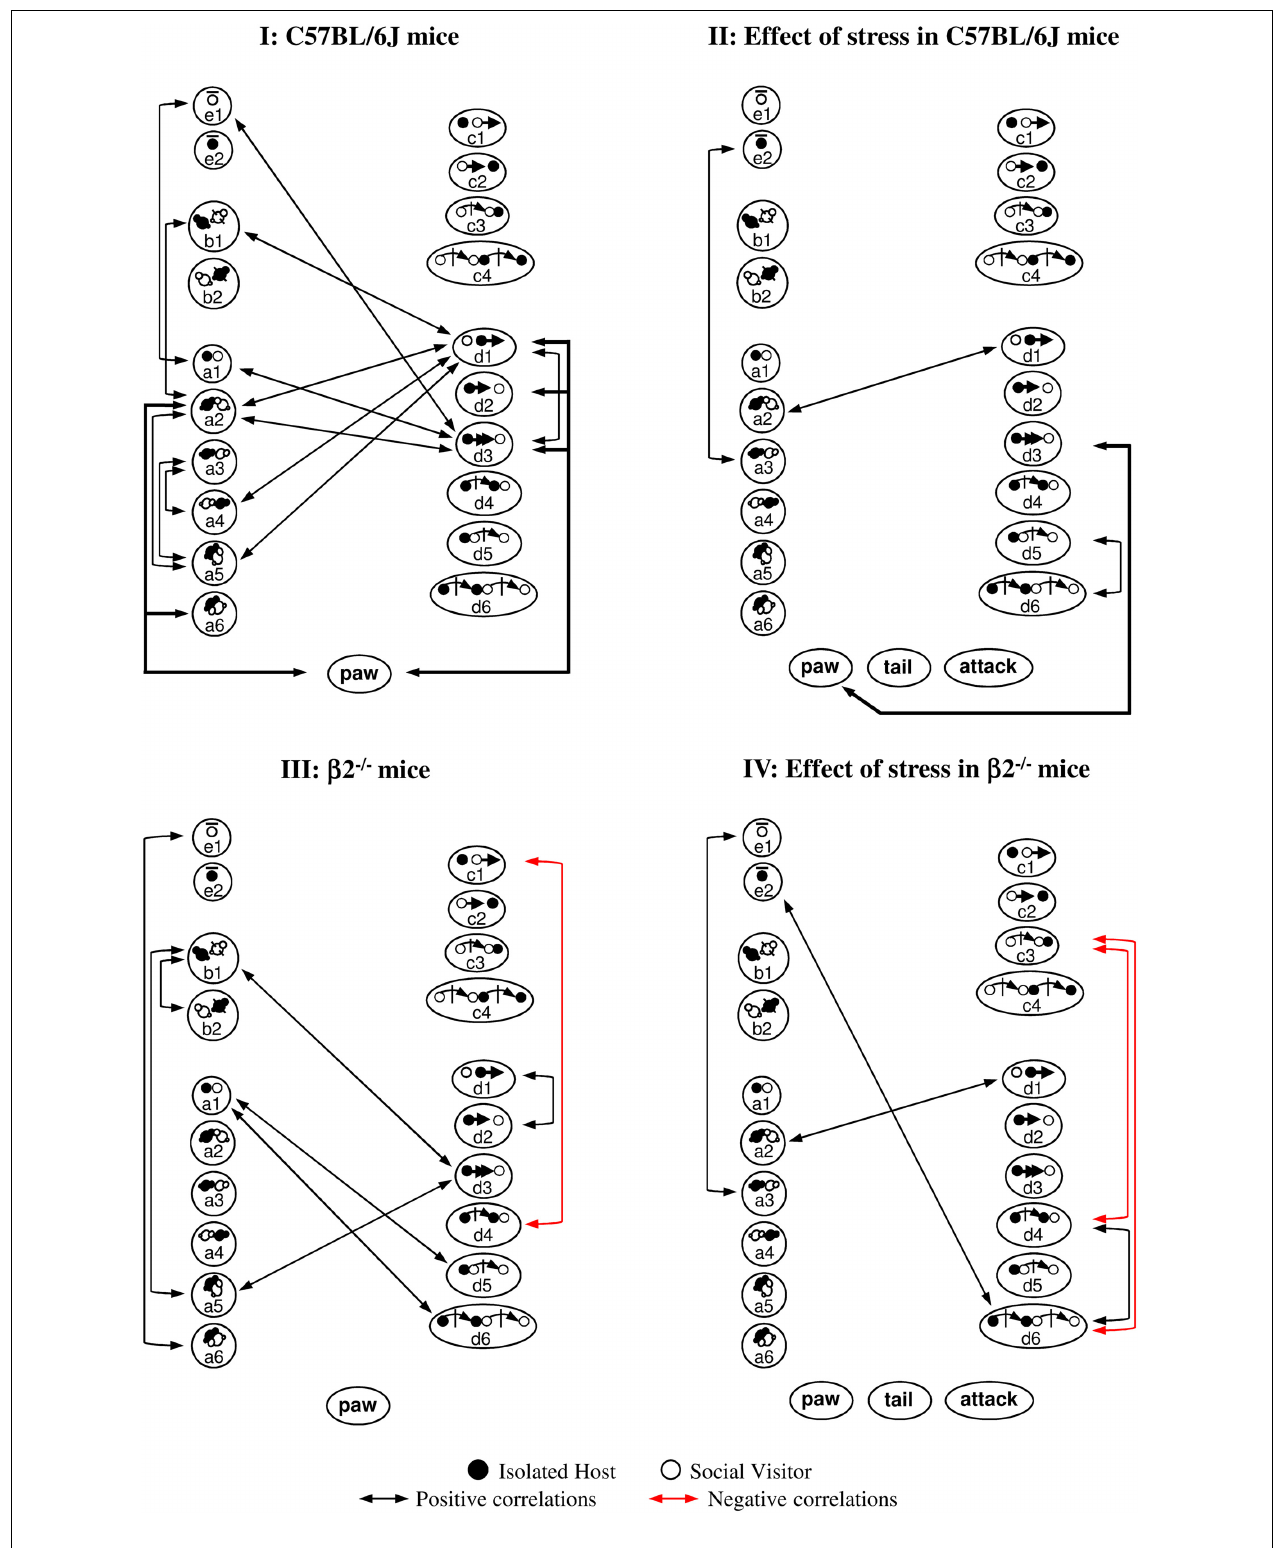
(0 . 0000002 ≤ p ≤ 0 . 002), red arrows negative ones ( p = 0 . 0000002). (I) C57BL/6J mice. All correlations were positive. Many contact events were correlated between them and some with d3 or d1 events. Events initiated by